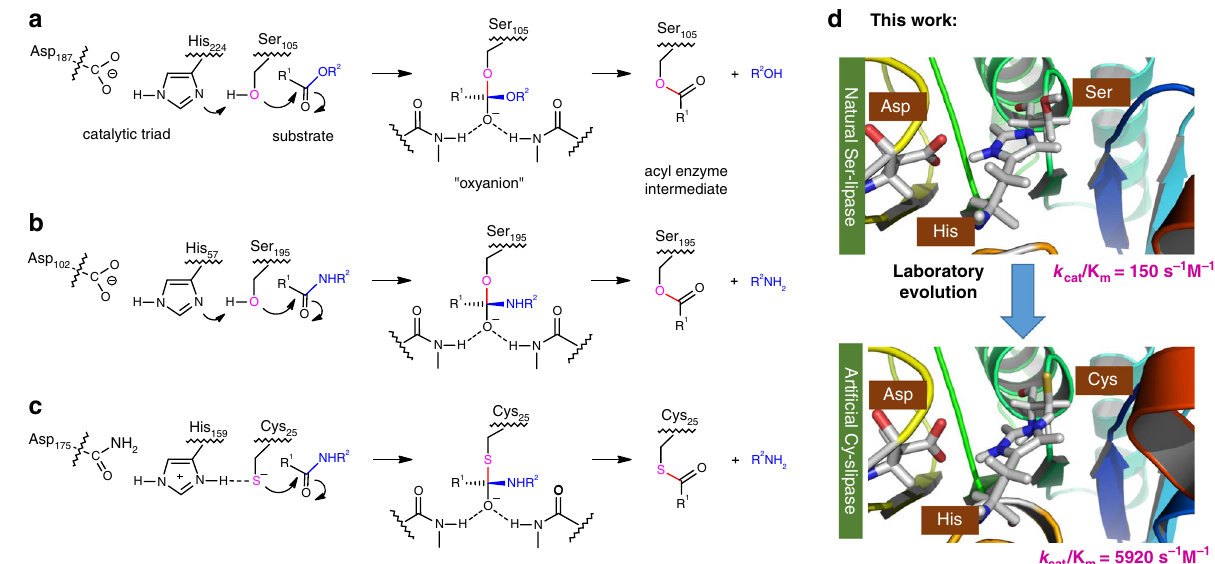
Fig. 1 Schematic representation of the catalytic mechanism of natural hydrolases and arti fi cial cys-lipase. a Lipases (CALB residue numbering). b Serine proteases (Trypsin residue numbering). c Cysteine proteases (Papain residues numbering). d Arti fi cial cys-lipase evolved from natural ser-lipase (kinetic data referred to the hydrolysis reaction of model substrate 1